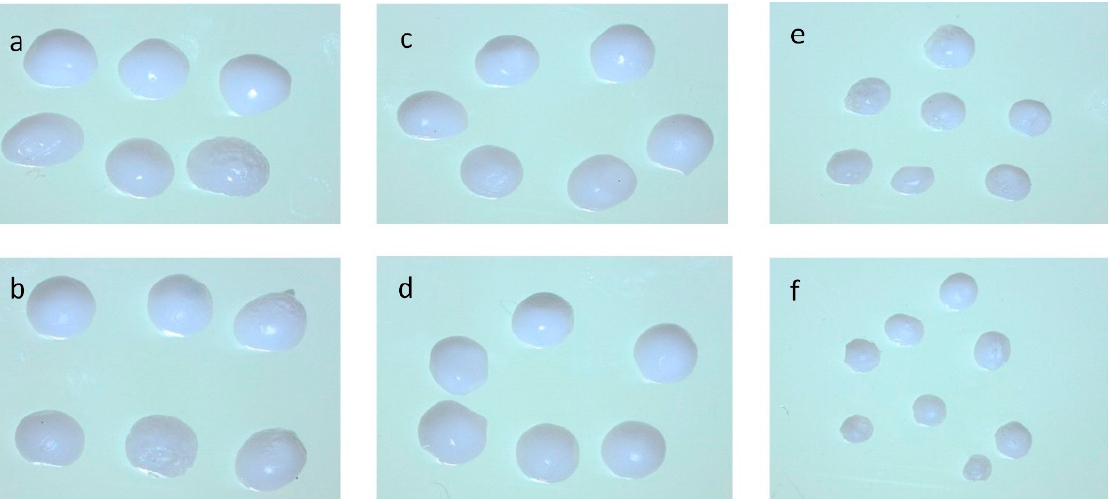
Figure 5. Optical image of citronella-oil-encapsulated beads with varying time: ( a ) 0 min; ( b ) 4 min; ( c ) 6 min; ( d ) 8 min; ( e ) 10 min; and ( f ) 12 min.